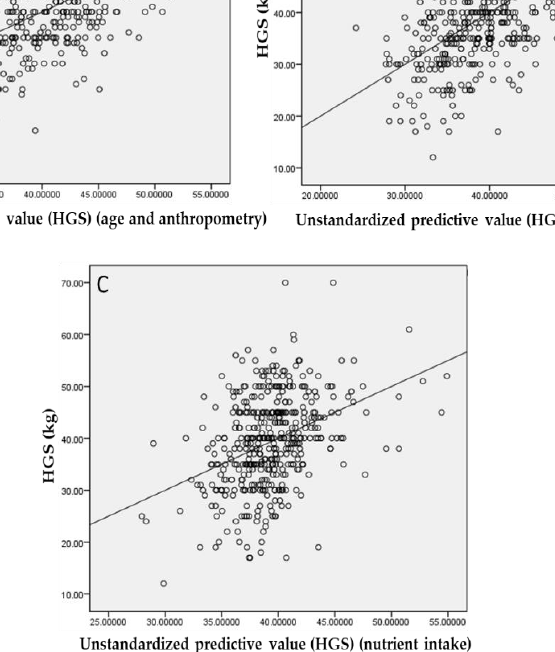
Figure 3. Multiple regression analyses between HGS and age and anthropometry (( A ) R 2 = 0.360), body composition (( B ) R 2 = 0.347), and nutrient intake (( C ) R 2 = 0.146). ( n = 432). Abbreviations: HGS, handgrip strength.